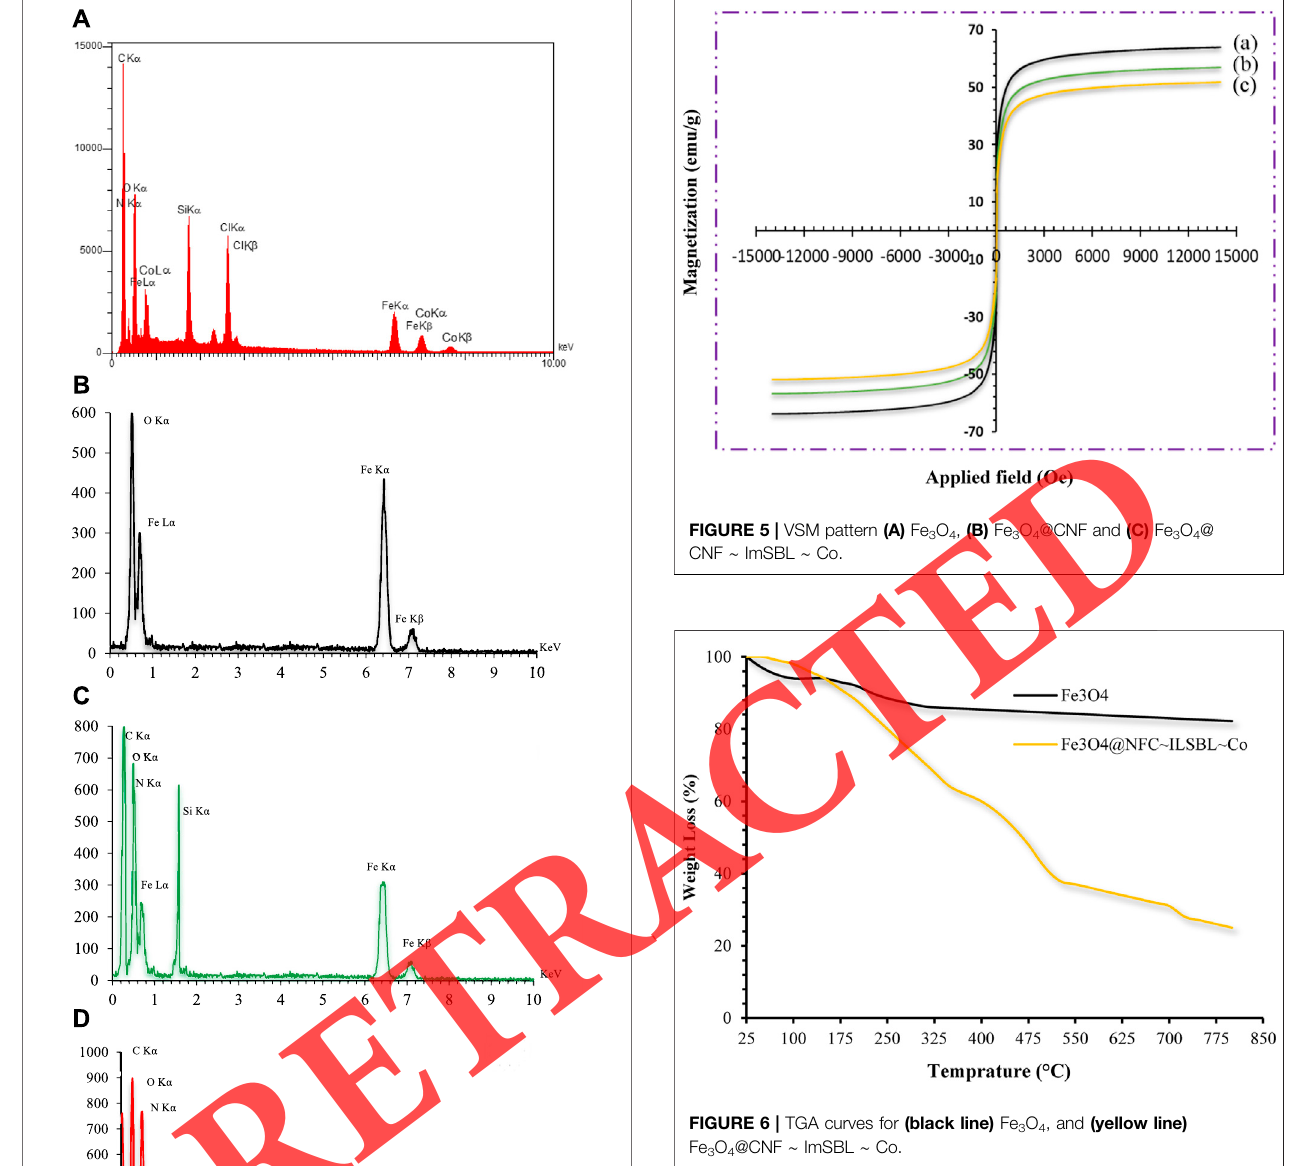
Fe 3 O 4 NPs and core – shell magnetic Fe 3 O 4 @CNF ∼ ImSBL ∼ Co. were determined by using the Debye – Scherrer (d {hkl} (cid:1) 0.94 λ / β cos θ ) equation where ß is the half-width of the highest intensity X-ray diffraction lines, d is the average crystalline diameter, 0.94